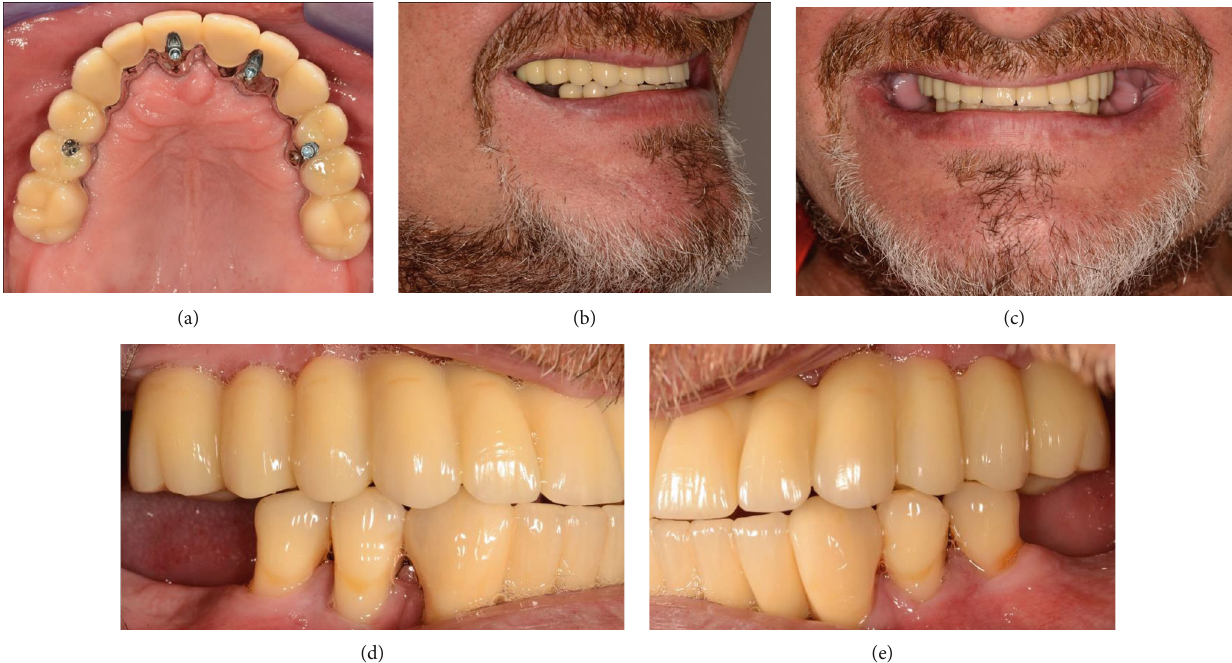
Figure 12: (a) Axial view of the de fi nitive FDP. (b) Right view of the patient smile. (c) Frontal view of the patient smile. (d) Right view of the de fi nitive FDP. (e) Left view of the de fi nitive FPD.